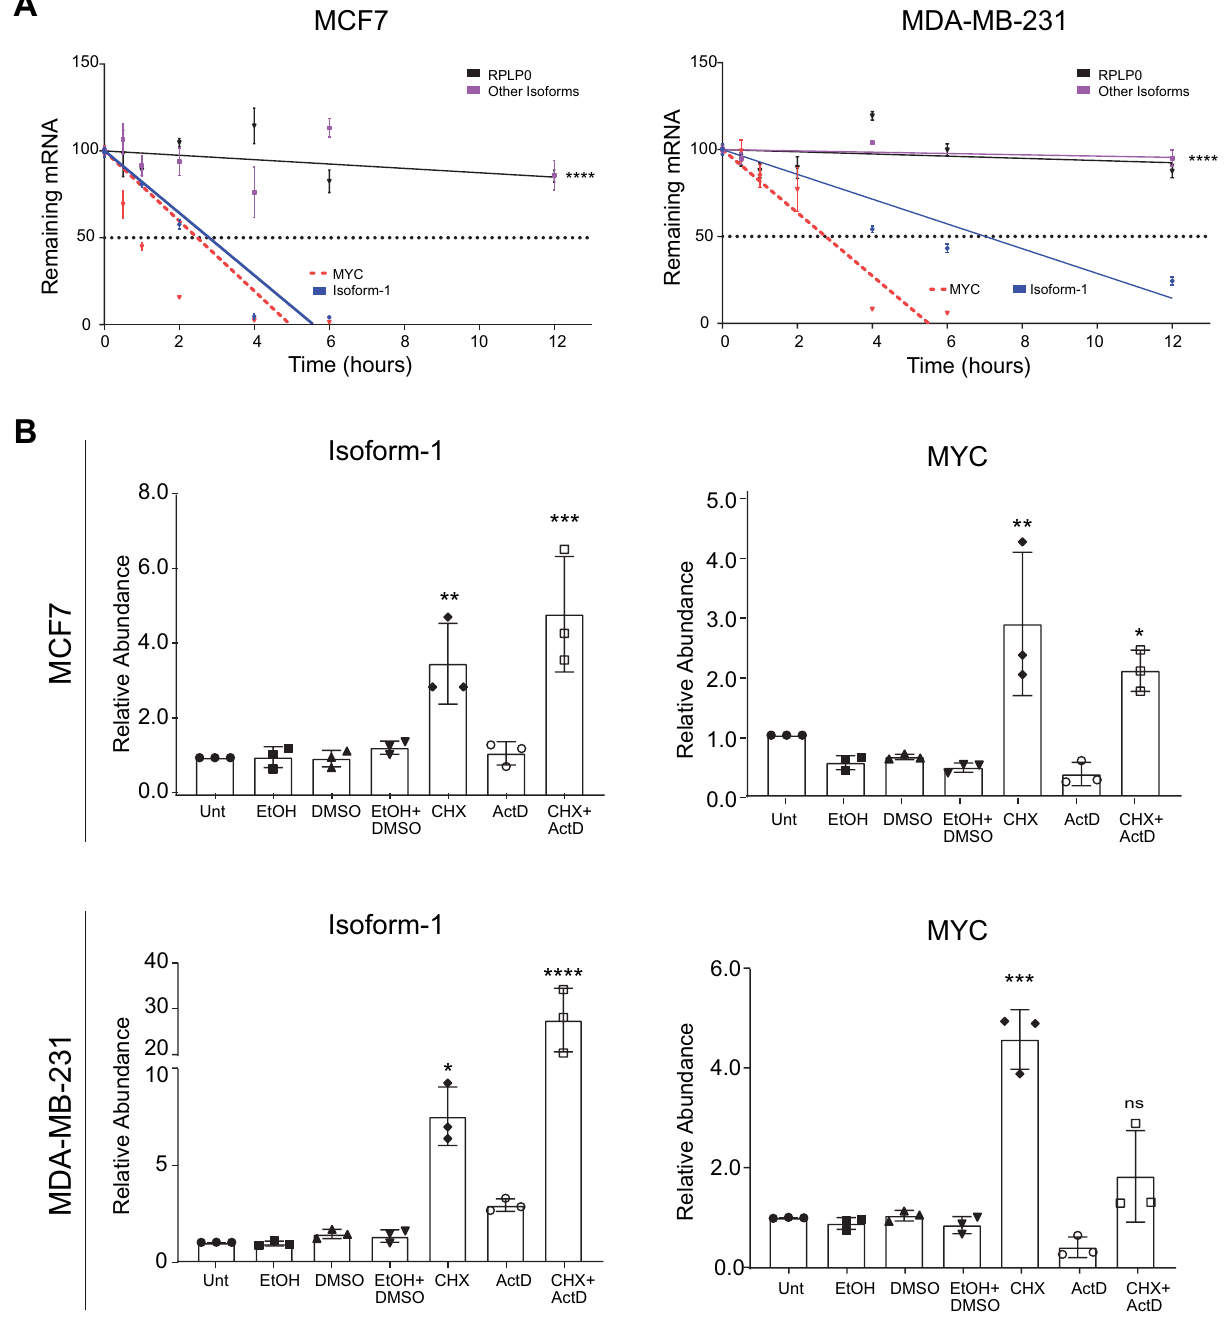
Figure 4. Stabilities of isoforms. ( A ) Remaining HNRNPA1 transcripts in actinomycin D treated cells were detected by RT-qPCR. RPLP0 as a stable mRNA and MYC as an unstable mRNA were used as controls (n = 3 independent treatments, ****p < 0.0001; n = 3, Student’s t-test). ( B ) Cells were treated with actinomycin D and/or cycloheximide (CHX, 100 µg/mL) for 3 h to prevent transcription and translation. EtOH (Ethanol) and DMSO are carrier controls. Cells were collected and RNA was isolated for RT-qPCR (*p < 0.05, **p < 0.01, ***p < 0.001, ****p < 0.0001, ns: not significant, n = 3 independent experiments, student’s